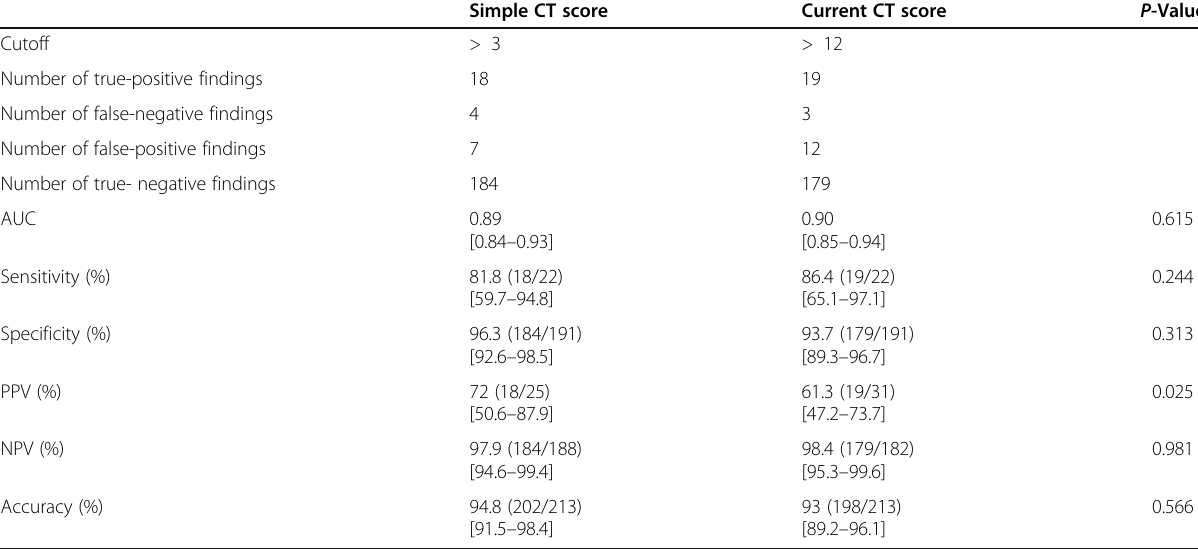
Table 4 Validity of both scores for predicting survival outcome using the consensus data Simple CT score Current CT score P -Value >